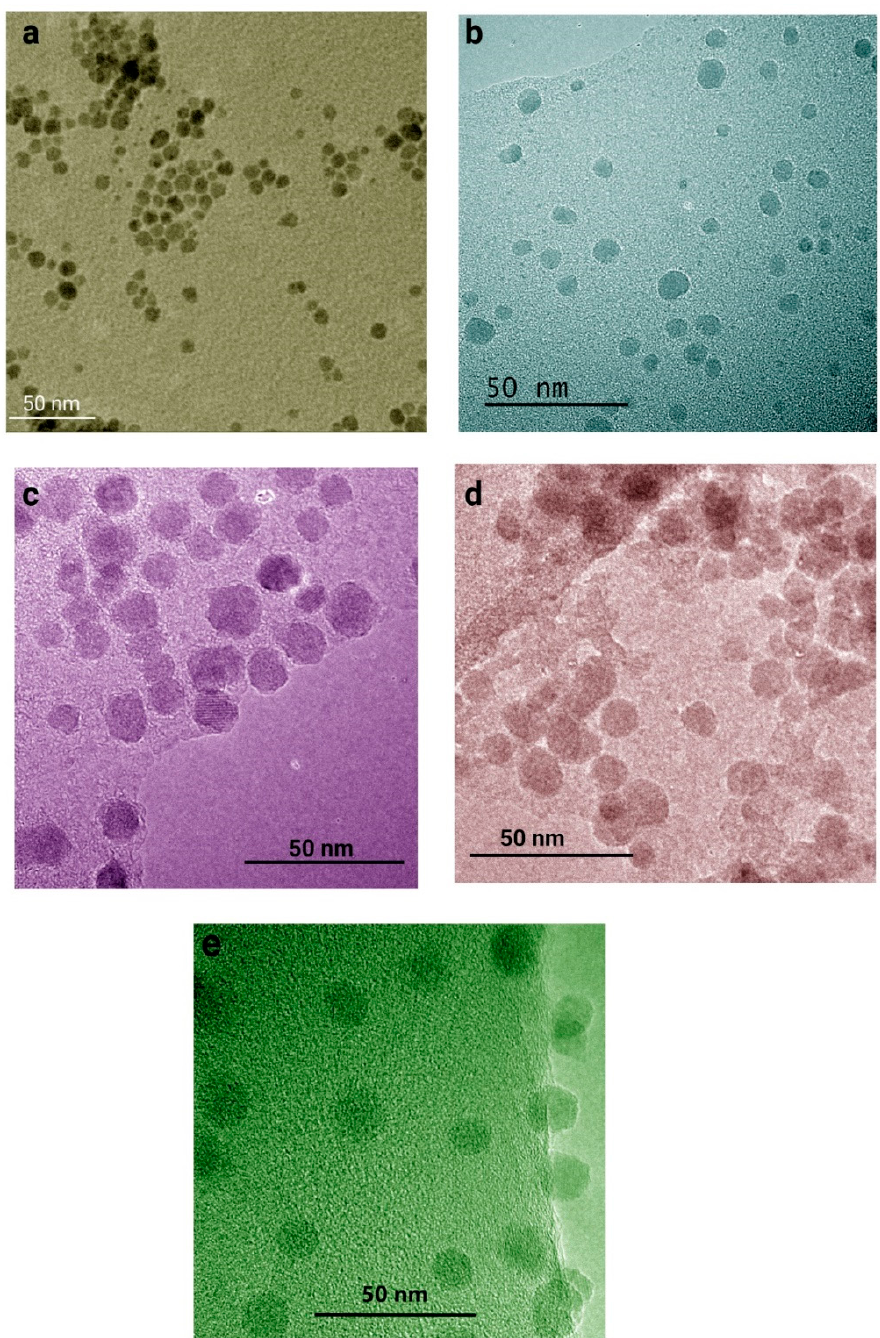
Figure 4. UHR-TEM analysis of ( a ) Fe 3 O 4 , ( b ) Fe 3 O 4 @HPG, ( c ) Fe 3 O 4 @SiO 2 , ( d ) Fe 3 O 4 @SiO 2 @HPG, and ( e ) Fe 3 O 4 @SiO 2 @HPG-FA.